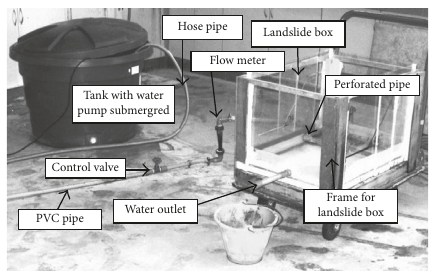
Figure 3: Layout of fabricated apparatus.